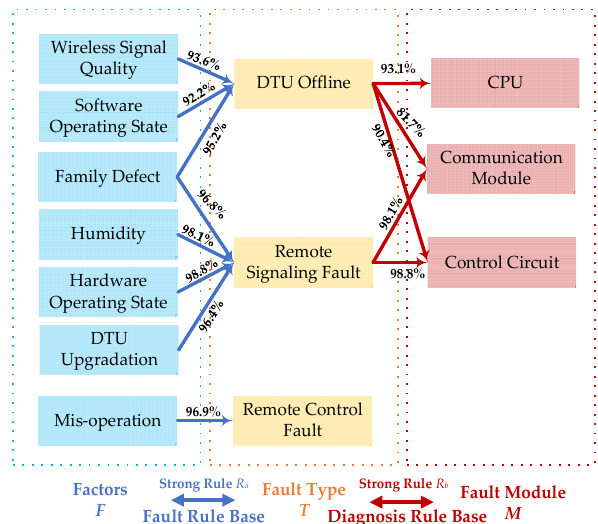
Figure 6. The fault rule base and diagnosis rule base.